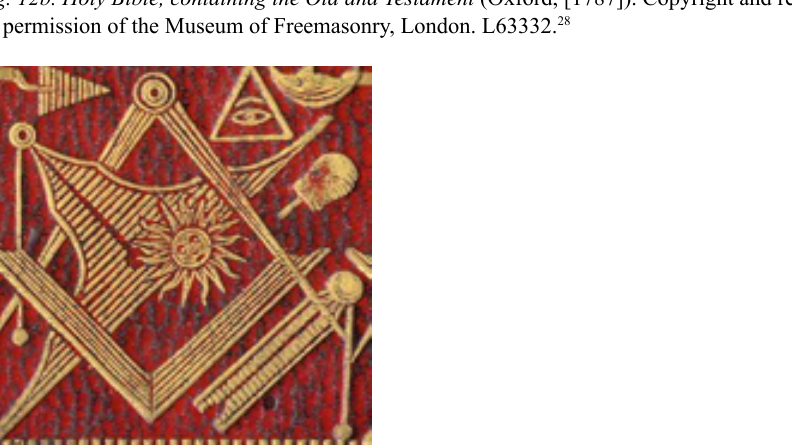
Fig 12c. Laurence Dermott, Ahiman Rezon (London, 1787). Copyright and reproduced by permission of the Museum of Freemasonry, London. L2313